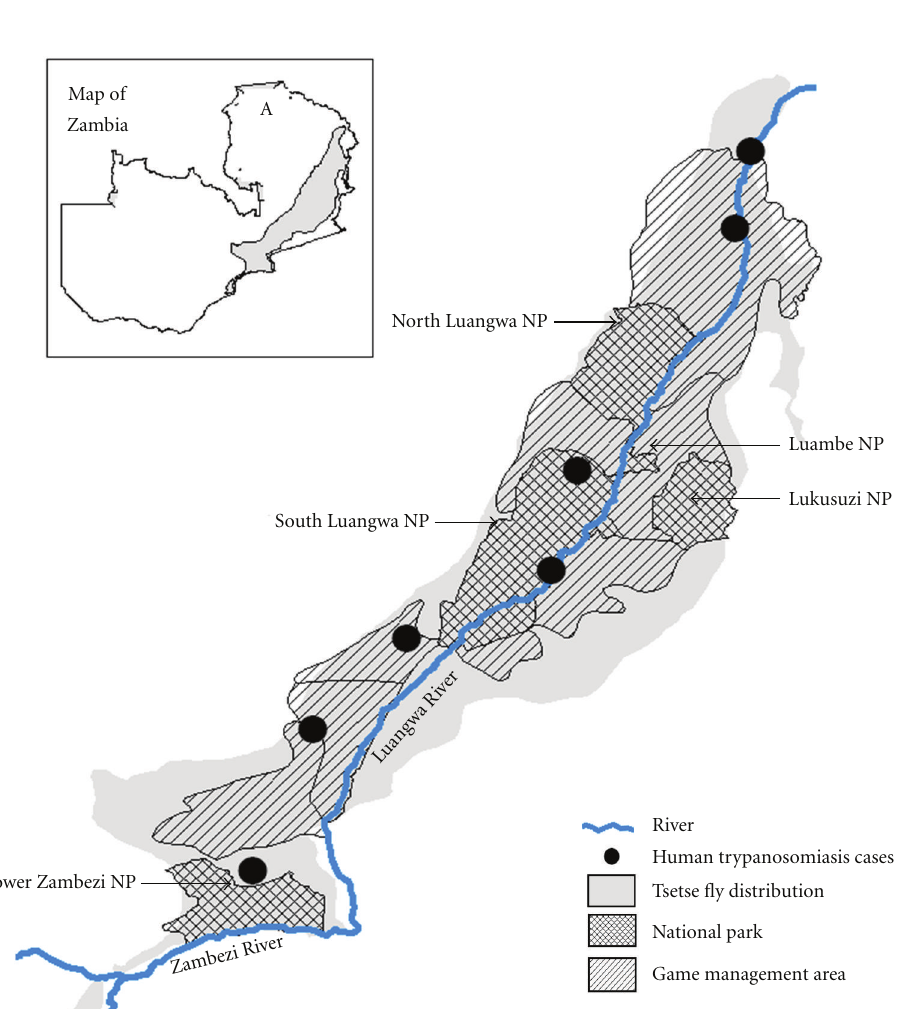
Figure 2: Shows the distribution of the tsetse infested areas overlapping the distribution of National Parks and Game Management Areas. Black dots show areas of clinical human trypanosomiasis cases, while insert shows the map of Zambia with A showing the study